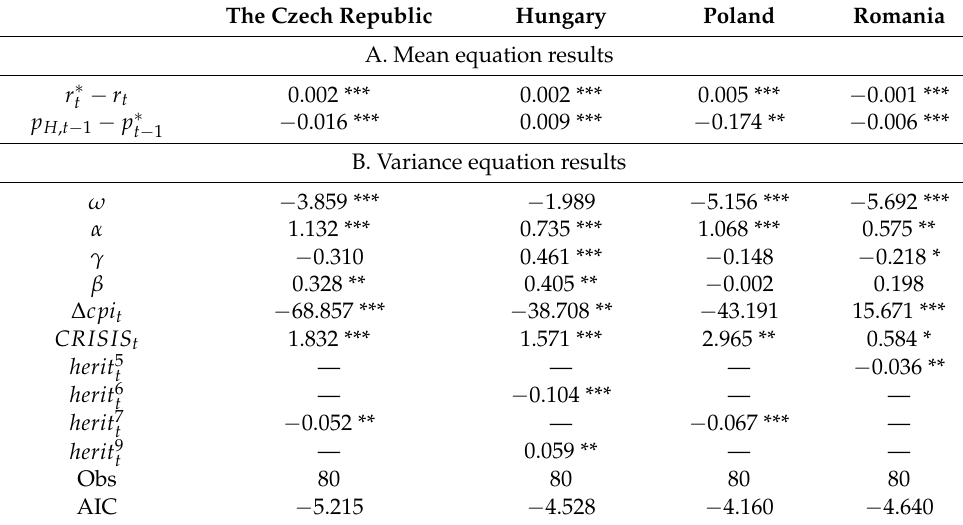
Table 4. Univariate EGARCH results (extended model).